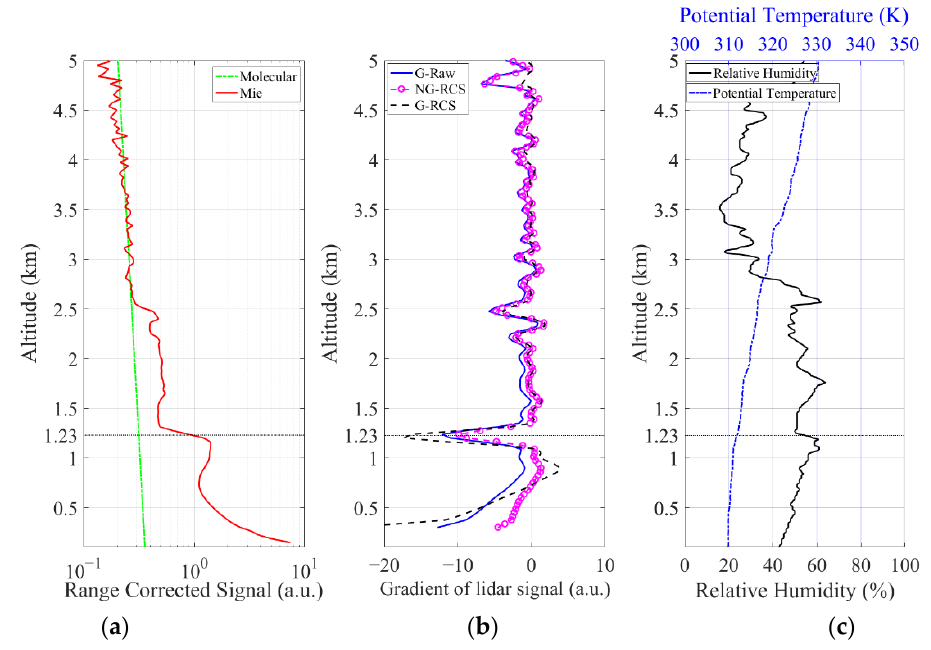
Figure 6. ( a ) Profiles of RCS and atmospheric molecular signal at 19:15, 20 July 2019; ( b ) Gradient profiles obtained by G-Raw, NG-RCS, and G-RCS; ( c ) Profiles of PT and RH obtained by GTS1 Digital Radiosonde at 19:15, 20 July 2019.